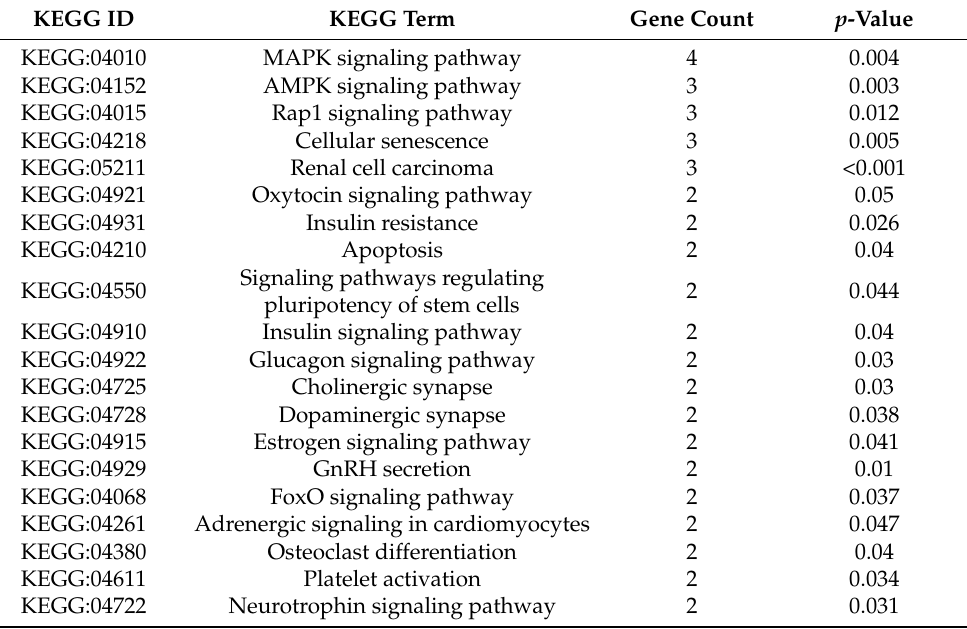
Figure 5. The interaction network represents KEGG pathways and potential target genes. Enriched pathways were obtained from the Kyoto Encyclopedia of Genes and Genomes (KEGG) database. Table 4. KEGG pathway analysis of target genes in GC patients with XELOX